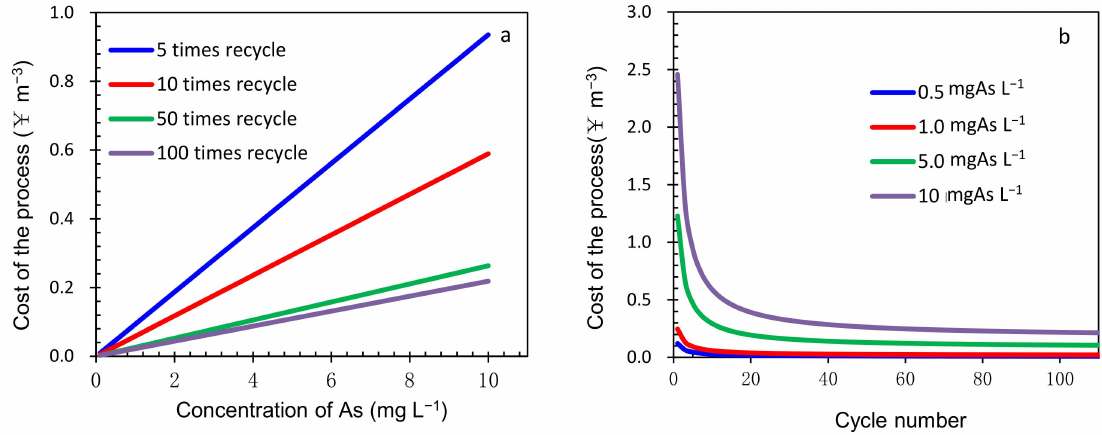
Figure 8. Effect of initial As concentration ( a ) and cycle time ( b ) on the operating